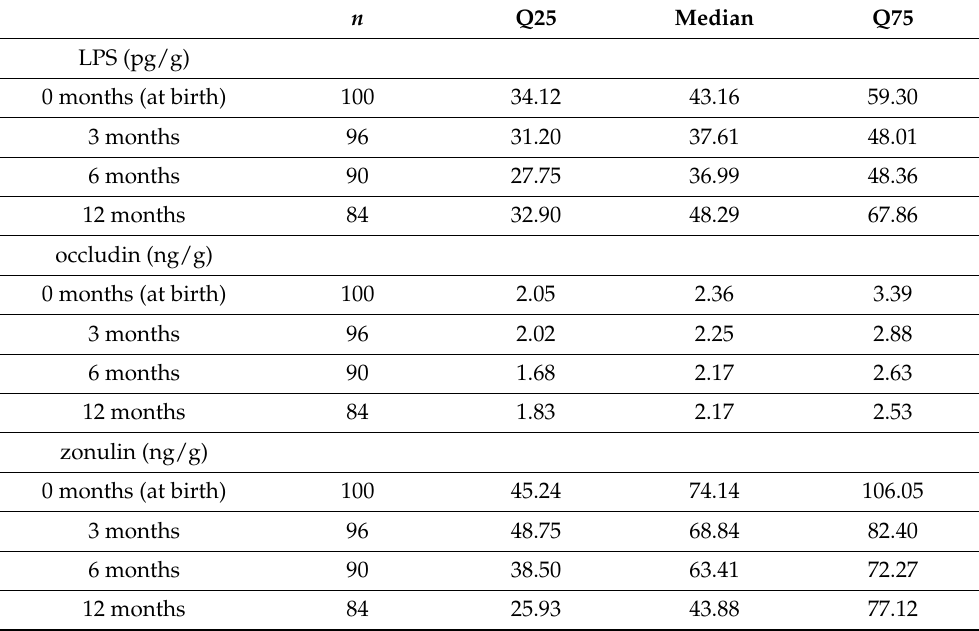
Table 2. Values of fecal lipopolysaccharide (LPS), occludin and zonulin in the examined children (nonparametric Mann–Whitney